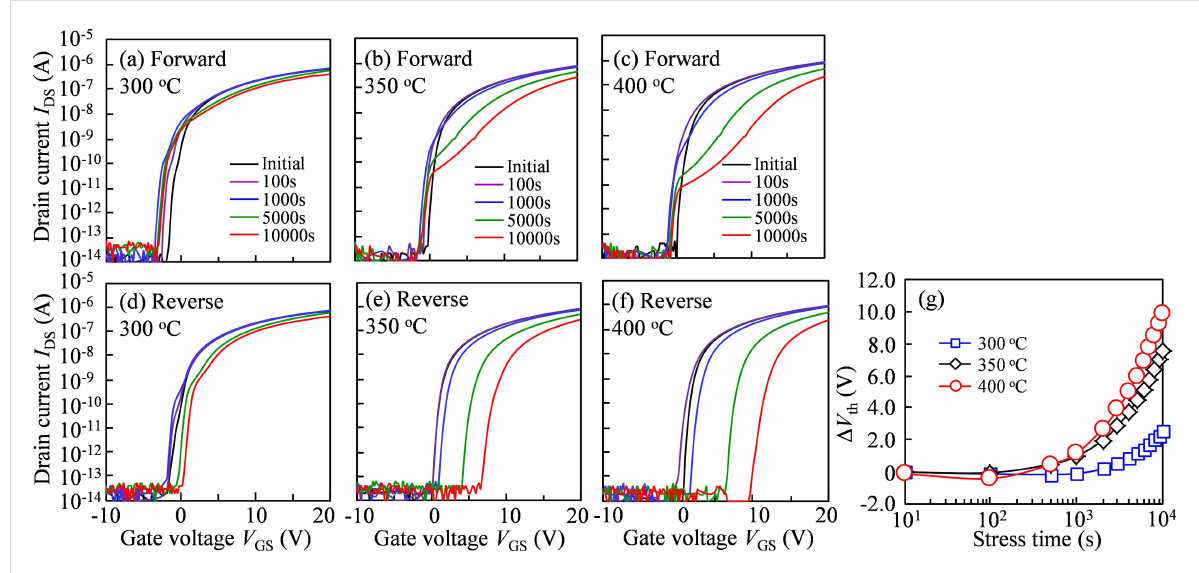
Figure 3: Transfer characteristics in the forward measurement for the devices annealed at (a) 300 °C, (b) 350 °C, and (c) 400 °C, and in the reverse measurement for the devices annealed at (d) 300 °C, (e) 350 °C, and (f) 400 °C as functions of stress duration under − 20 V V GS NBIS; (g) V th values of the transfer curves of the devices as a function of NBIS